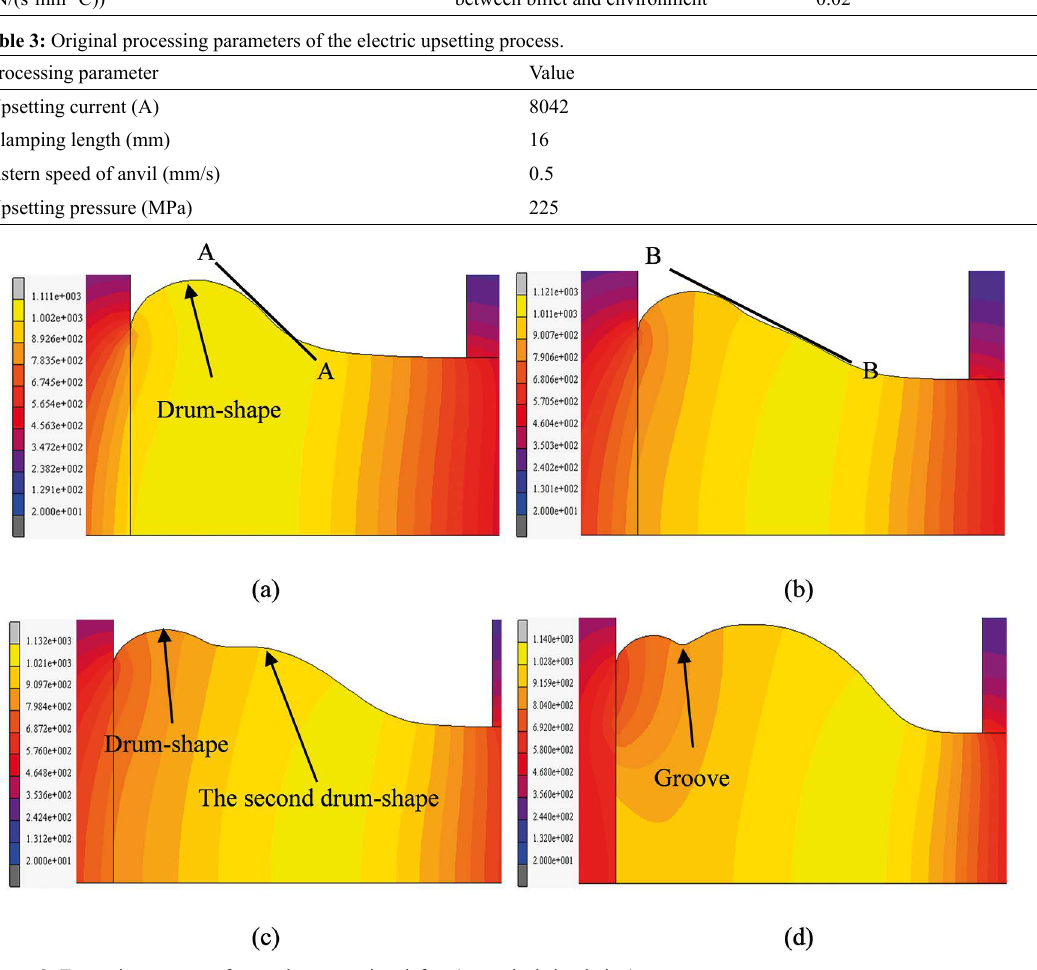
Figure 8: Formation process of secondary upsetting defect (numerical simulation).